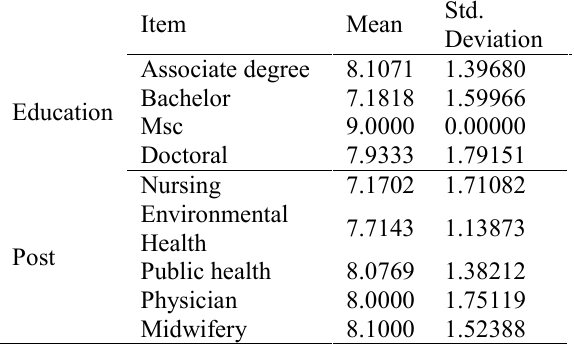
Table 3. Mean participant food safety knowledge scores Item